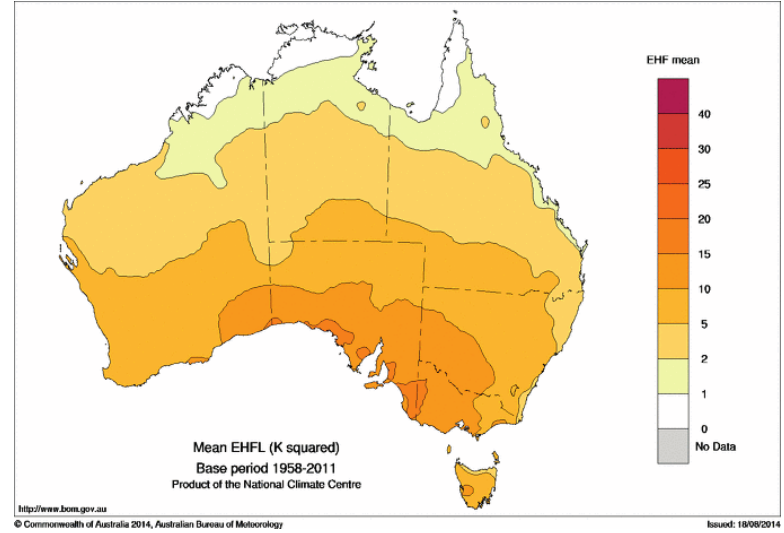
Figure 6. Mean positive EHF, in K 2 , based on all positive EHF values in the period